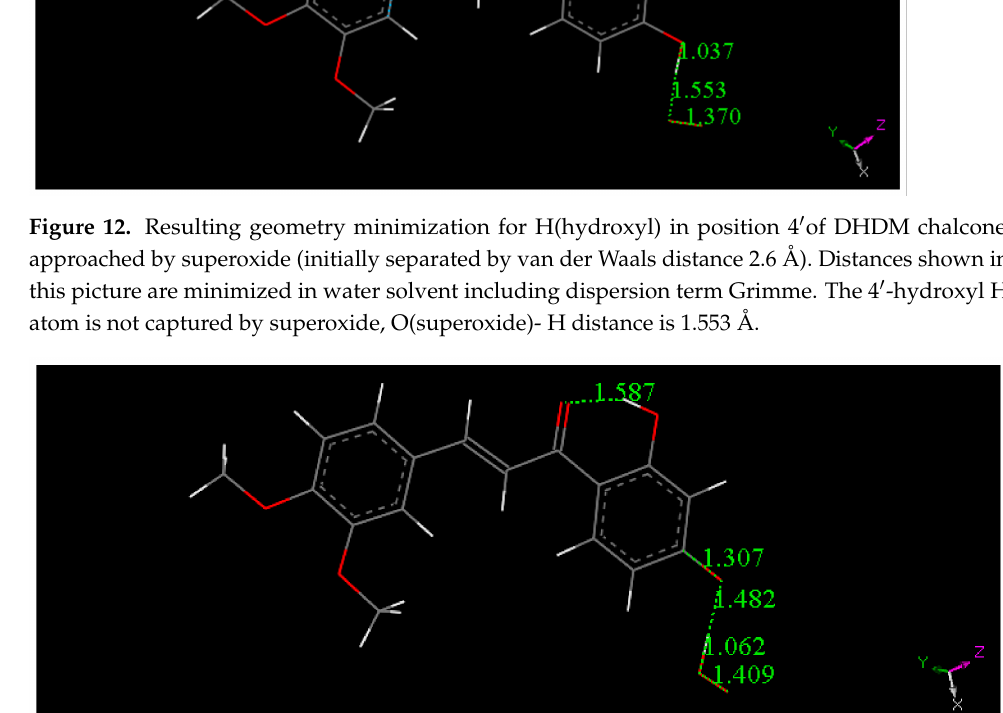
Figure 13. Result of geometry optimization after potential H(hydroxyl) capture by van der Waals separated superoxide to form O 2 H, bottom right, and DHDM semiquinone. This calculation shows no capture of H by the semiquinone, O-H distance of 1.482 Å. Calculation is done using water solvent and dispersion term Grimme. The Figure 12 structure is 1.6 kcal/mol lower in